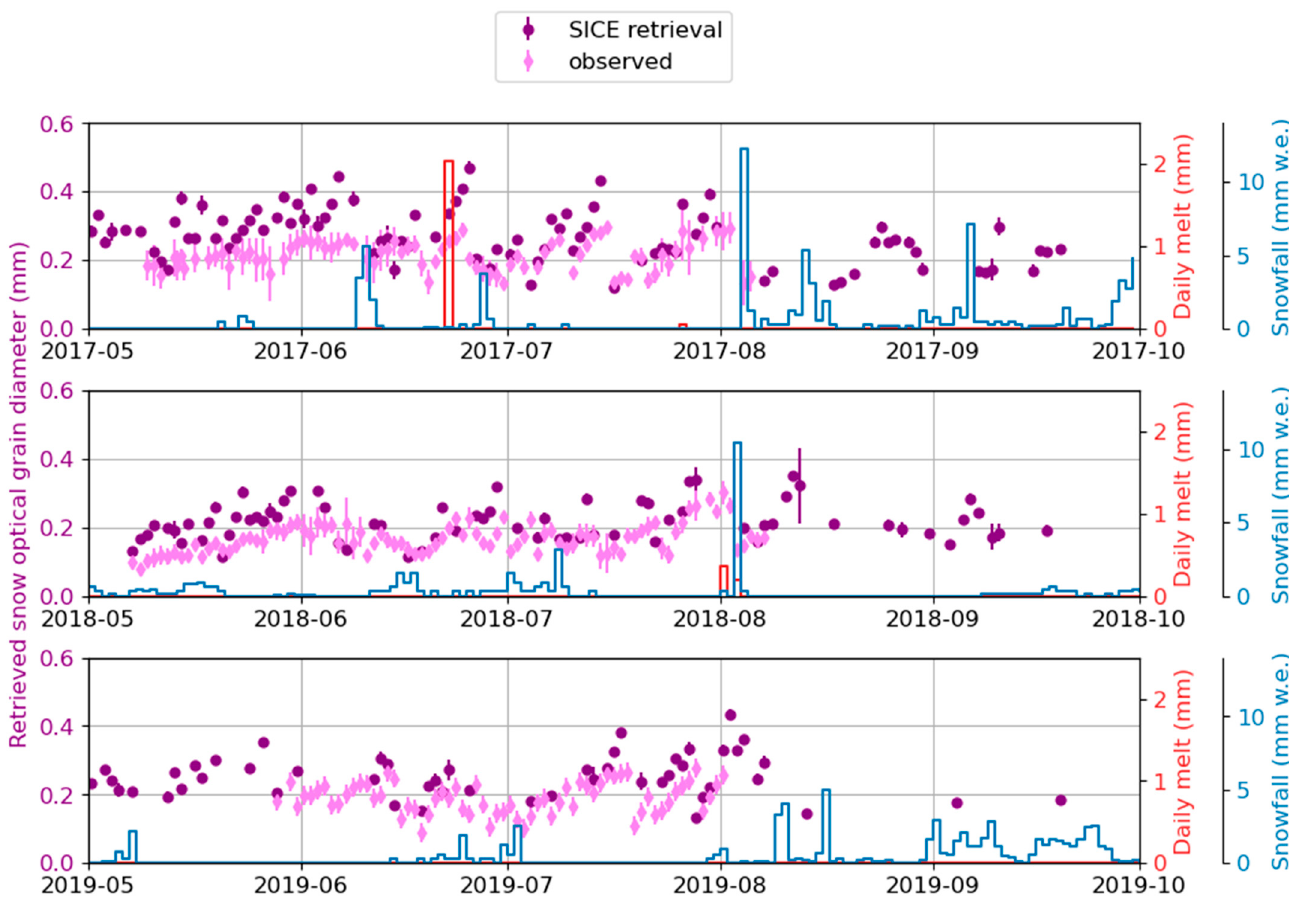
Figure 1. Observed and retrieved snow optical grain diameter ( d opt ) at EastGRIP during May–October 2017–2019. Error bars indicate the daily standard deviation along the 90 m transect for observation and within a 2 km radius for the retrieval. Sonic ranger-derived snowfall and melt rate calculated from the PROMICE EGP AWS data.